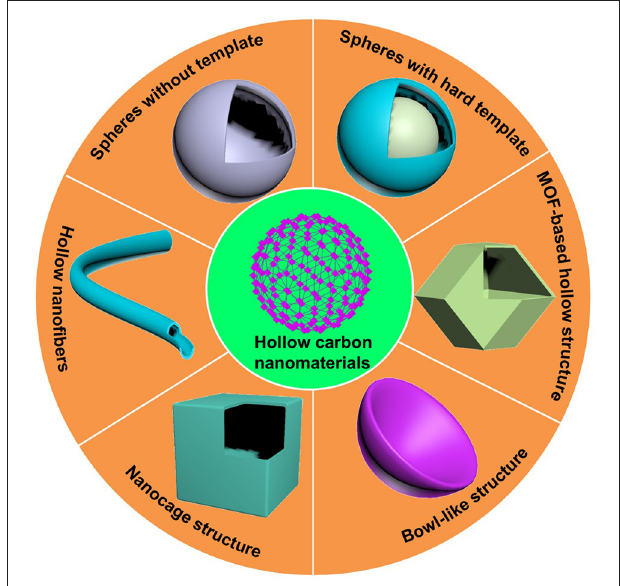
FIGURE 1 | Schematic illustration of various carbon nanomaterials with hollow